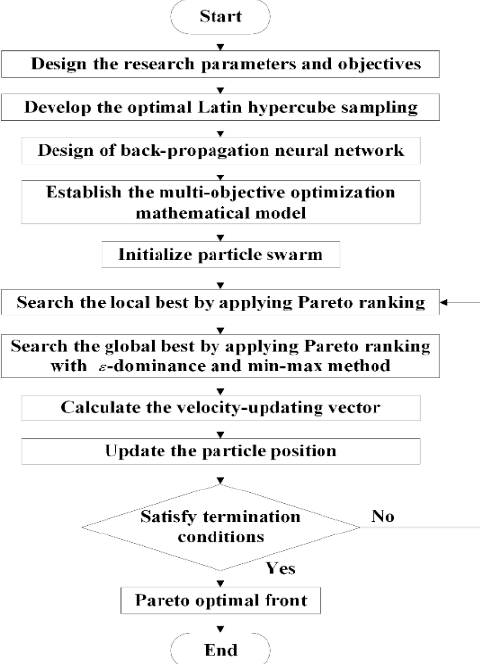
Figure 15. Flowchart of the multi-objective optimization method based on MOPSO algorithm with ε -dominance.